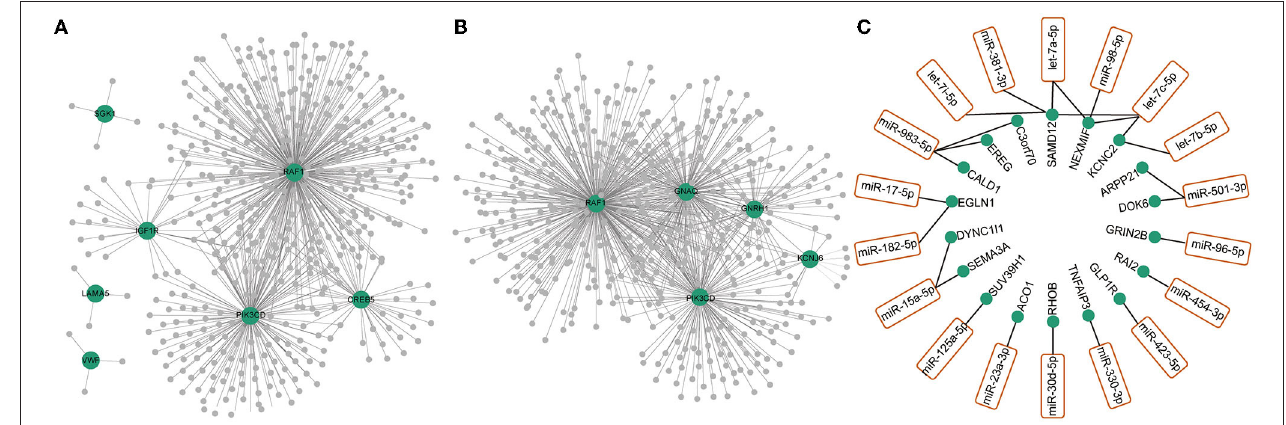
FIGURE 3 | Co-expression network of differentially expressed RNAs (mRNAs, lncRNAs, circRNAs and miRNAs) with differentially expressed RNAs in GnRH secretion (A) and PI3K-Akt signaling pathway (B) . The green dots represented the differentially expressed mRNAs in GnRH secretion (A) and PI3K-Akt signaling pathway (B) . The gray dots represented the differentially expressed ncRNAs (lncRNAs, circRNAs, miRNAs) coexpressed with differentially expressed mRNAs in these two pathways. (C) Differentially expressed miRNAs (orange box) and their targeted mRNAs (green